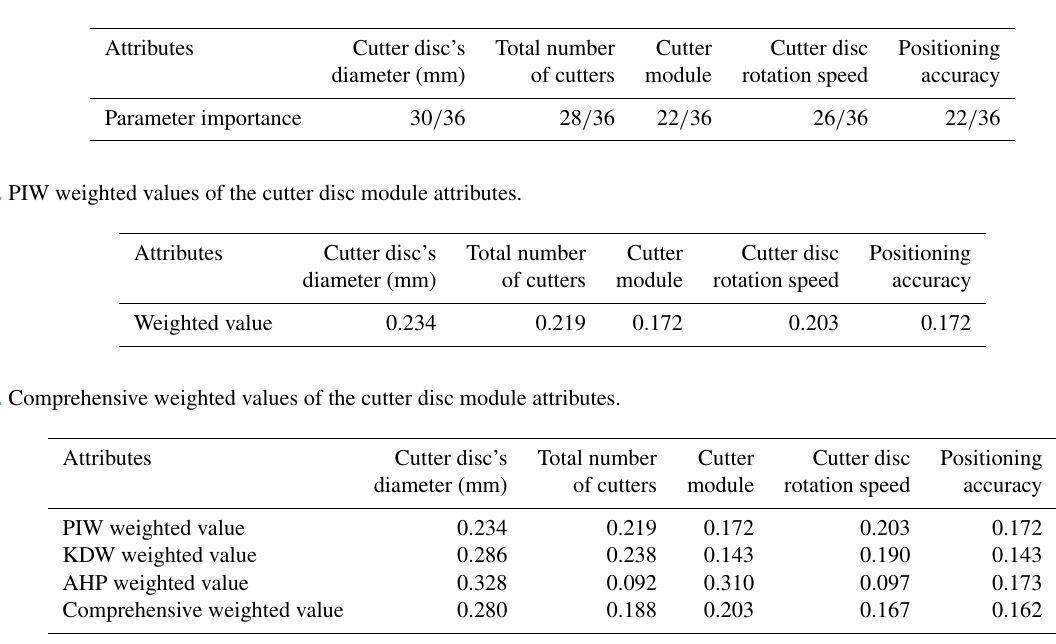
Table 4. Parameter importance of the cutter disc module attributes.